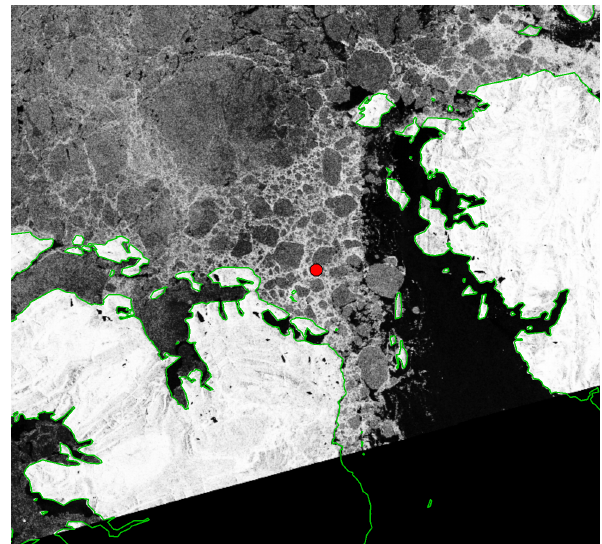
Figure 4. Multi-year pack ice in the Penny Strait on 23 August 2009. Ice-free water appears dark. A red dot marks the sonar’s lo- cation. (RADARSAT Data and Products © MacDonald, Dettwiler and Associates Ltd. (2010) – all rights reserved. RADARSAT is an official mark of the Canadian Space Agency.)